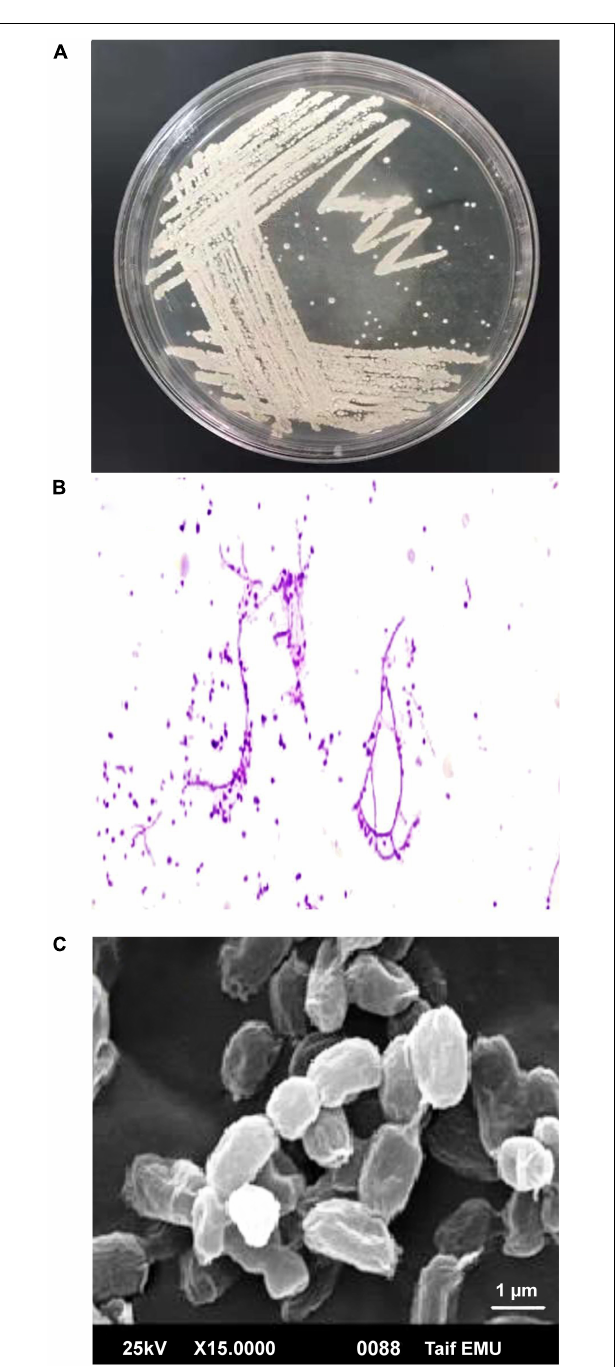
FIGURE 2 | Morphological characteristics of Nocardiopsis dassonvillei M1. (A) Colonies on PDA plates. (B) Light microscopic image of hyphae with magnification 40X. (C) Scanning electron microscope of